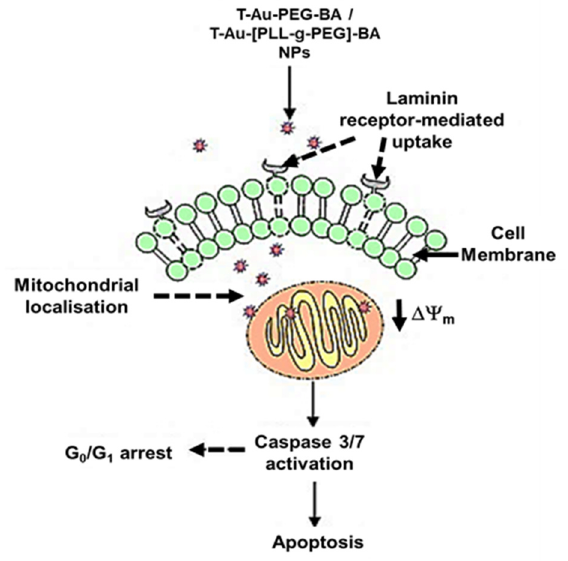
Figure 14. Illustration indicating possible mechanisms involved in cell death.